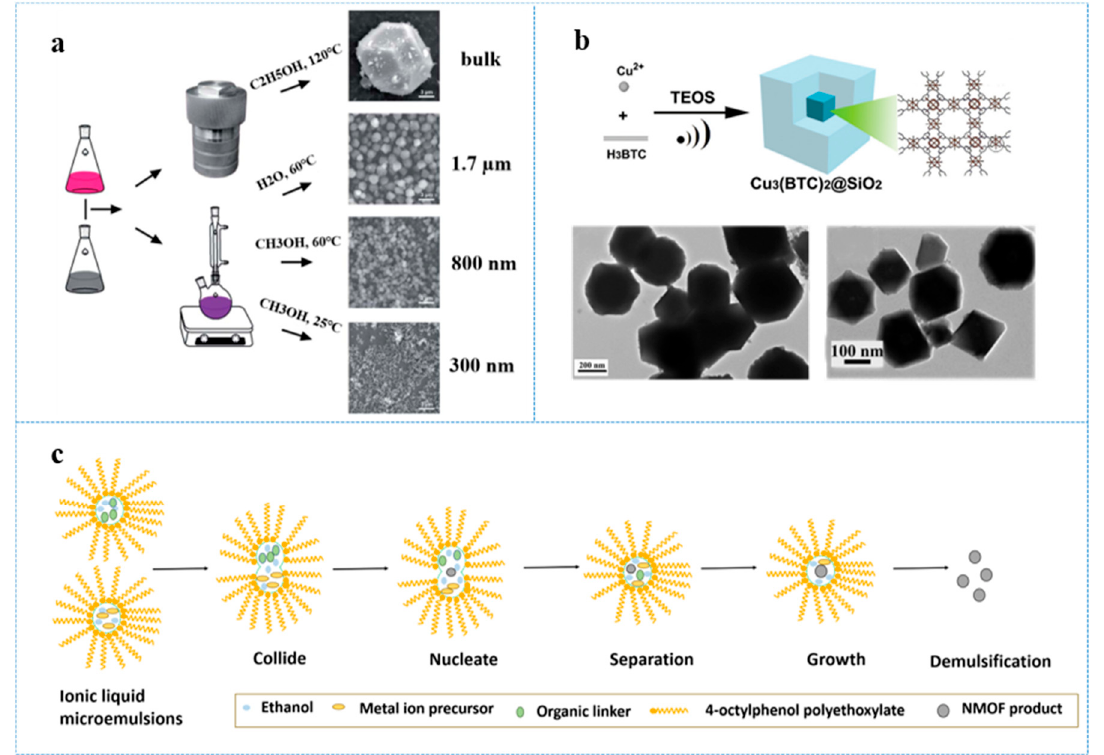
Figure 1. ( a ) Schematic illustration of synthesis of ZIF-67 with various sizes by solvothermal methods. Scale bars = 3 μ m; reprinted with modifications from Xia et al. [28]; ( b ) schematic representation of the synthesis of the Cu 3 (BTC) 2 @SiO 2 core–shell nanocrystals using ultrasonic method and the TEM images of as-synthesized Cu 3 (BTC) 2 @SiO 2 ; reprinted with modifications from Li et al. [32]; ( c ) schematic illustration of the growth mechanism of HKUST-1 nanoparticles prepared in an ionic liquid-containing microemulsion system, adapted from Zheng et al. [33].